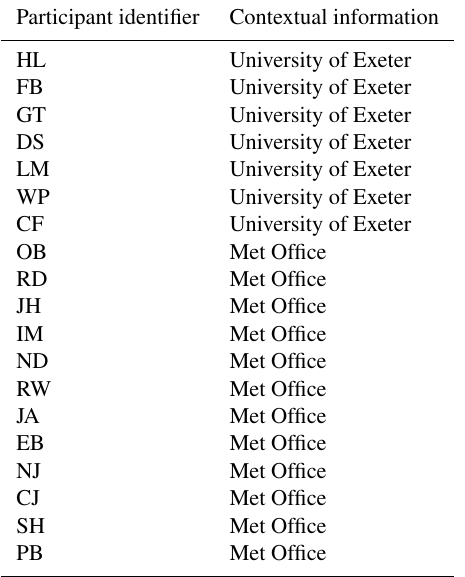
Table 1. Full list of participants in the Climate Stories project. Table 2. List of artistic project leads (Climate Stories) referred to by